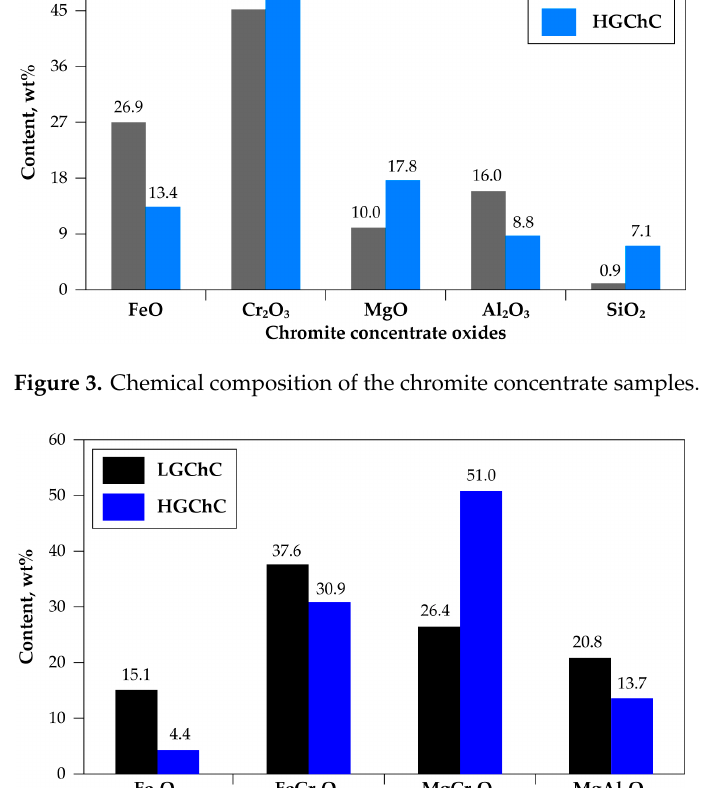
Figure 3. Chemical composition of the chromite concentrate samples.